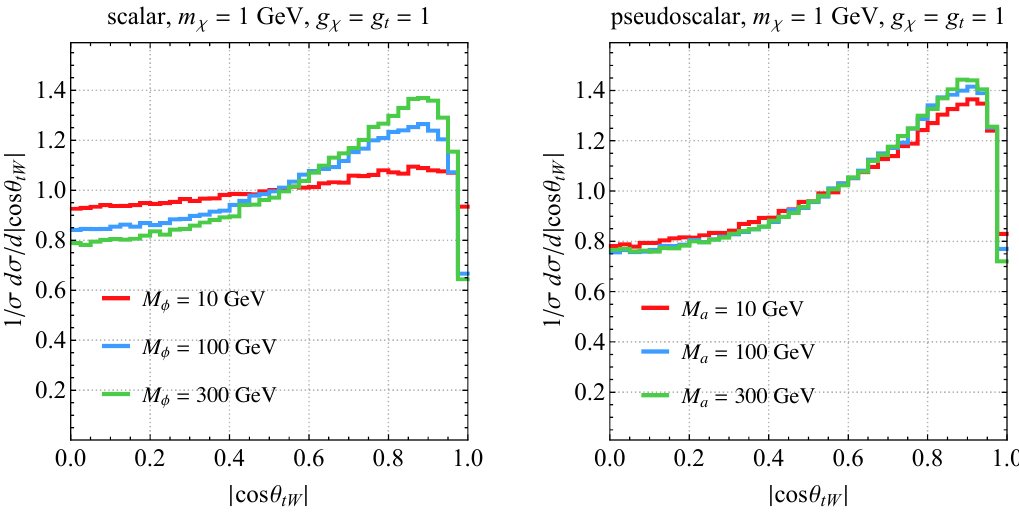
Figure 3 . Normalised j cos (cid:18) tW j distributions for the tW + E miss pseudoscalar (right) s -channel DM simpli(cid:12)ed model. The shown results correspond to the 14